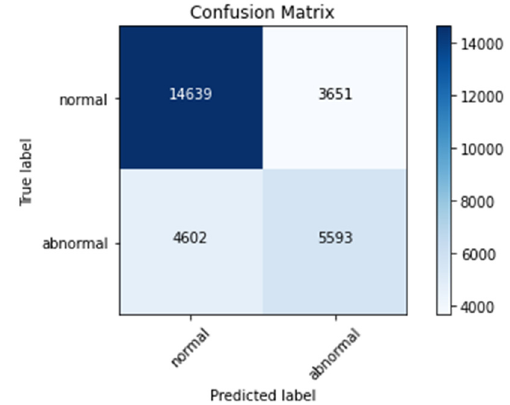
Figure 16. Confusion matrix for Model-1.